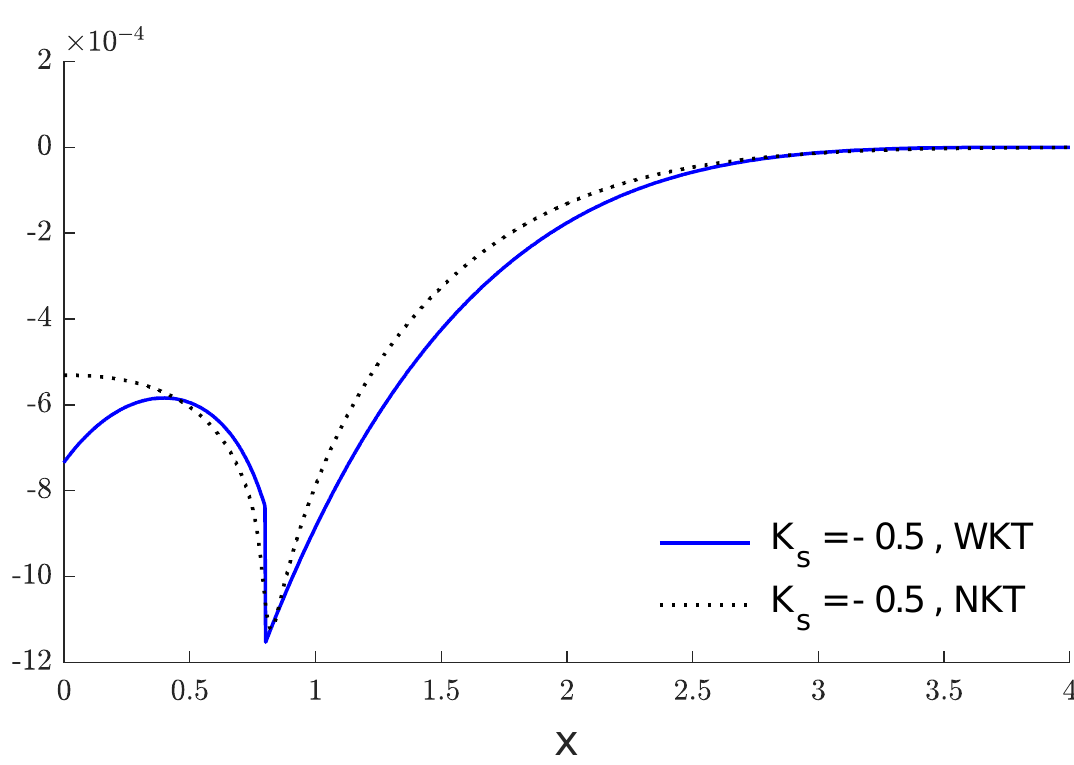
Figure 11. The variations of carrier density with and without Kirchhoff transforms when 𝐾 𝑠 = −0.5 .